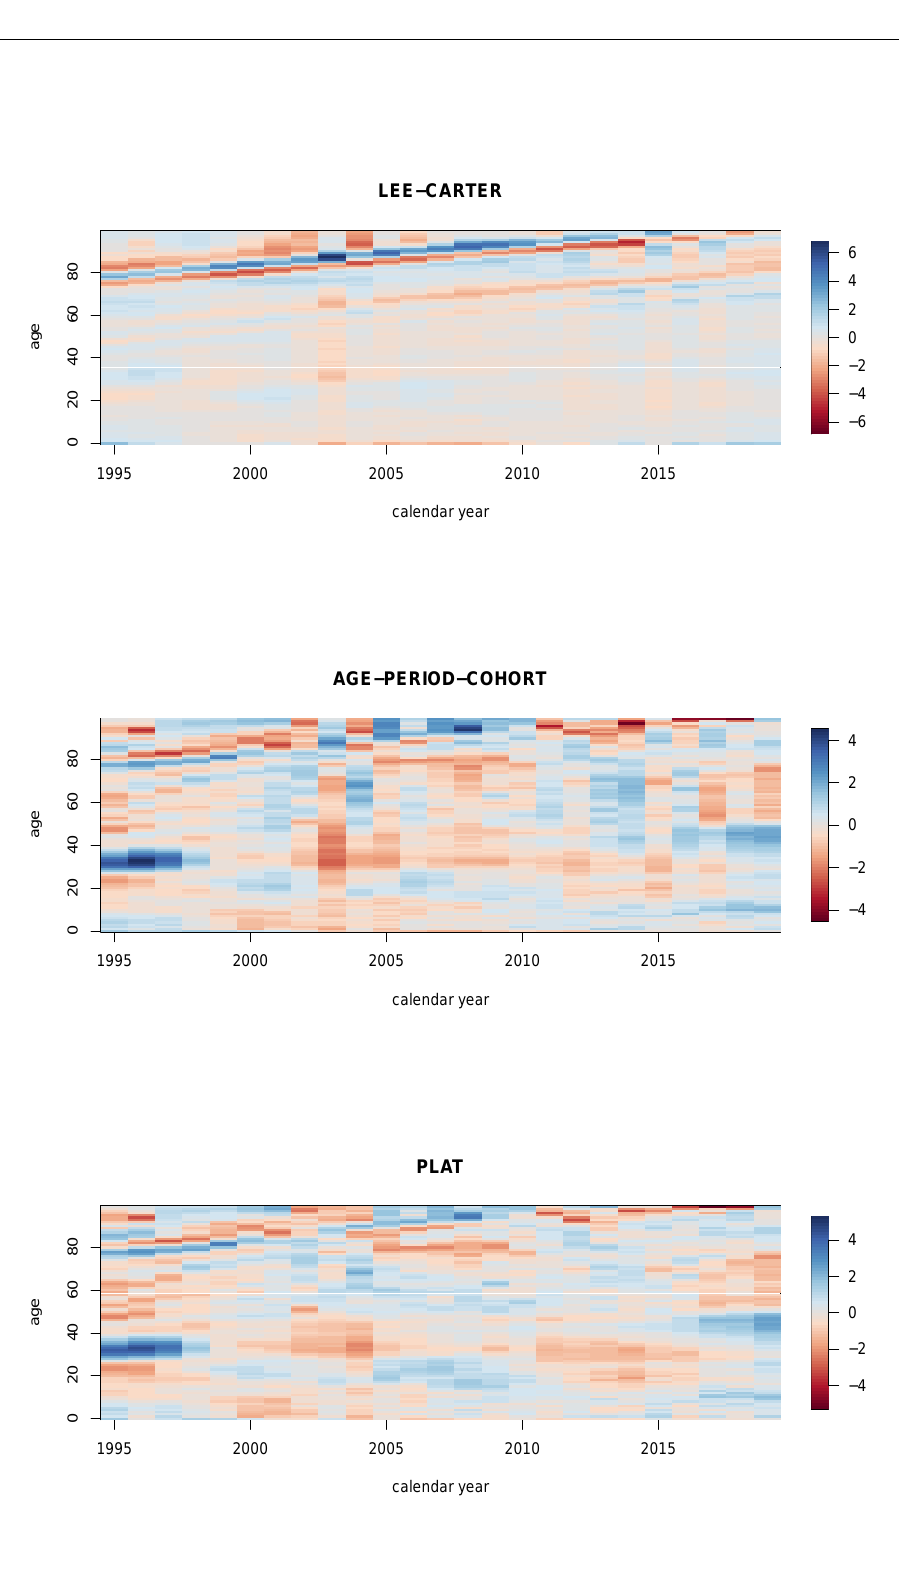
Figure A7. Comparison of LC, APC and PLAT Stochastic Mortality Models: period-by-age